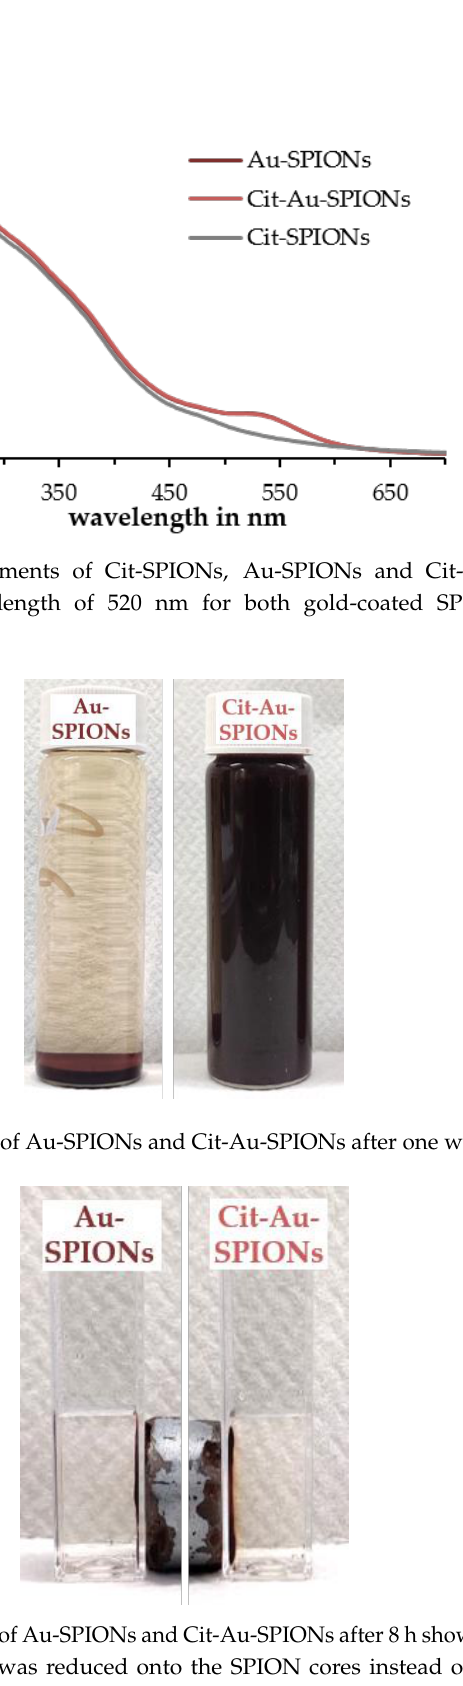
Figure A4. Energy dispersive X-ray spectra of ( a ) Cit-SPIONs and ( b ) Cit-Au-SPIONs. A gold related peak appeared after gold coating process. Figure A5. Transmission electron microscopy (TEM) images of ( a ) Cit-SPIONs and ( b ) Cit-Au-SPIONs.